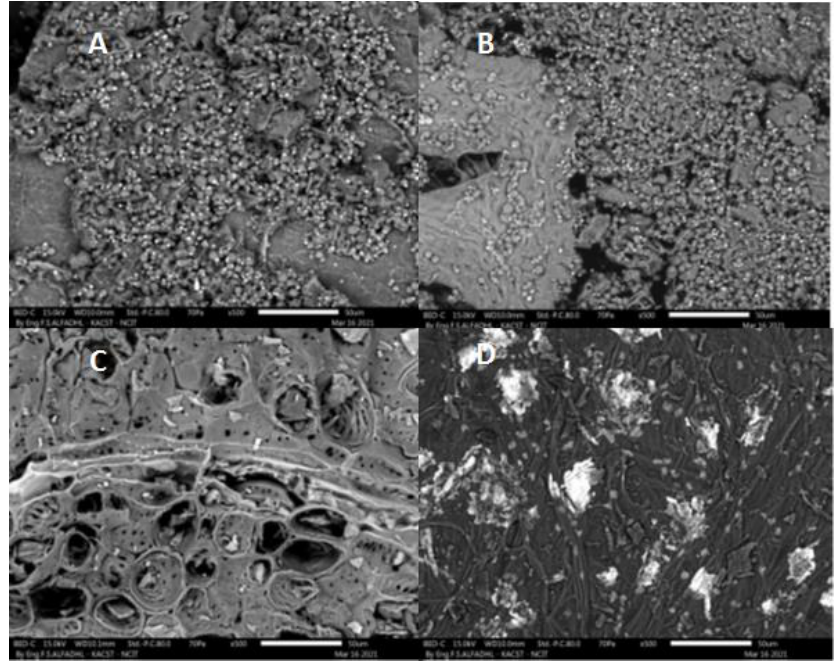
Figure 3. SEM micrograph of ( A ) CCSs pre- adsorption ( B ) CCSs post adsorption ( C ) CCPs pre- adsorption ( D ) CCPs post adsorption.